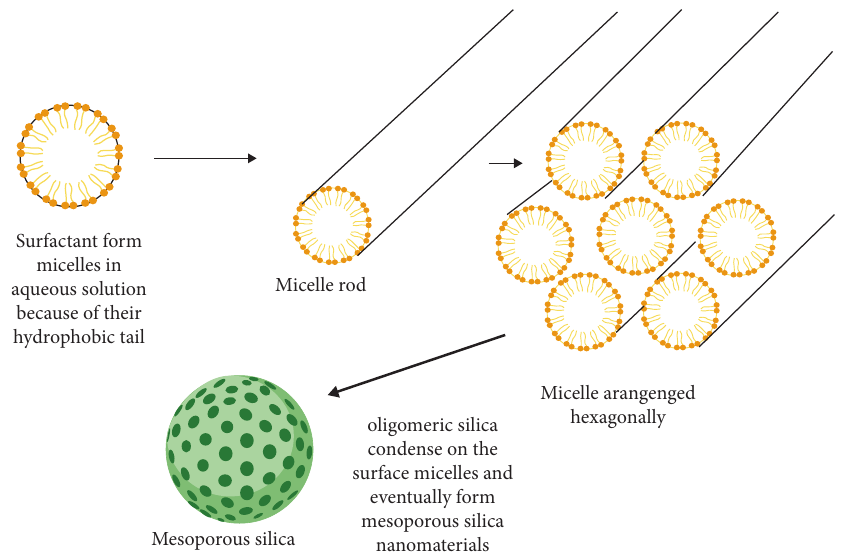
Figure 16: Formation of mesoporous silica